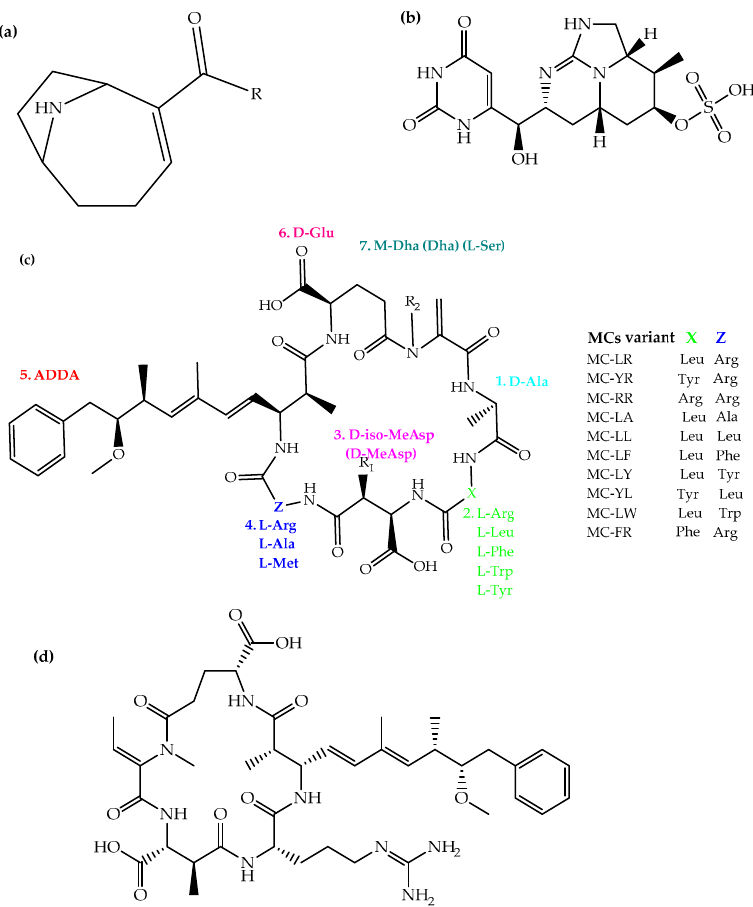
Figure 2. Chemical structure of some of the phycotoxins reported in East African Community lakes: ( a ) ATX and HATX (R = CH 3 and C 2 H 5 , respectively); ( b ) cylindrospermopsin; ( c ) microcystins: 1 to 7 are amino acid residues; congeners (variants) with different combinations of amino acids are shown; ( d ) nodularins.